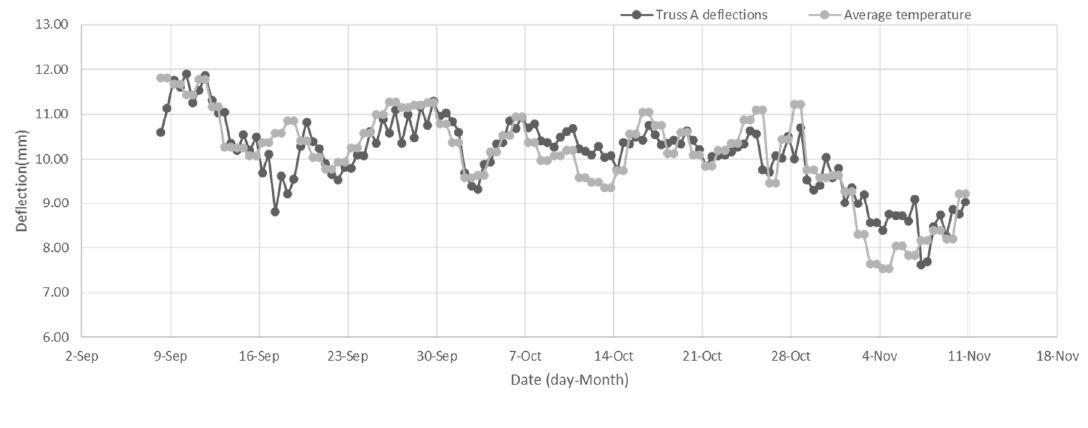
Figure 8. Correlation coefficient between deflection values and the environmental parameters.